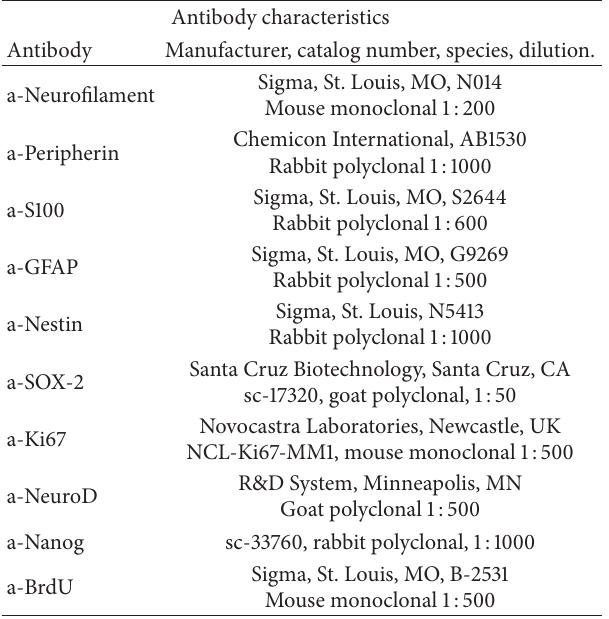
Table 1: Primary antibodies used for immunofluorescence. Antibody